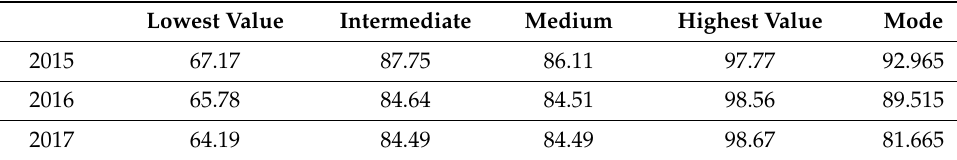
Figure 2. The admission ratio of the students for the three years. Table 2. The admission ratio of the students for the three years. Lowest Value Intermediate Medium Highest Value